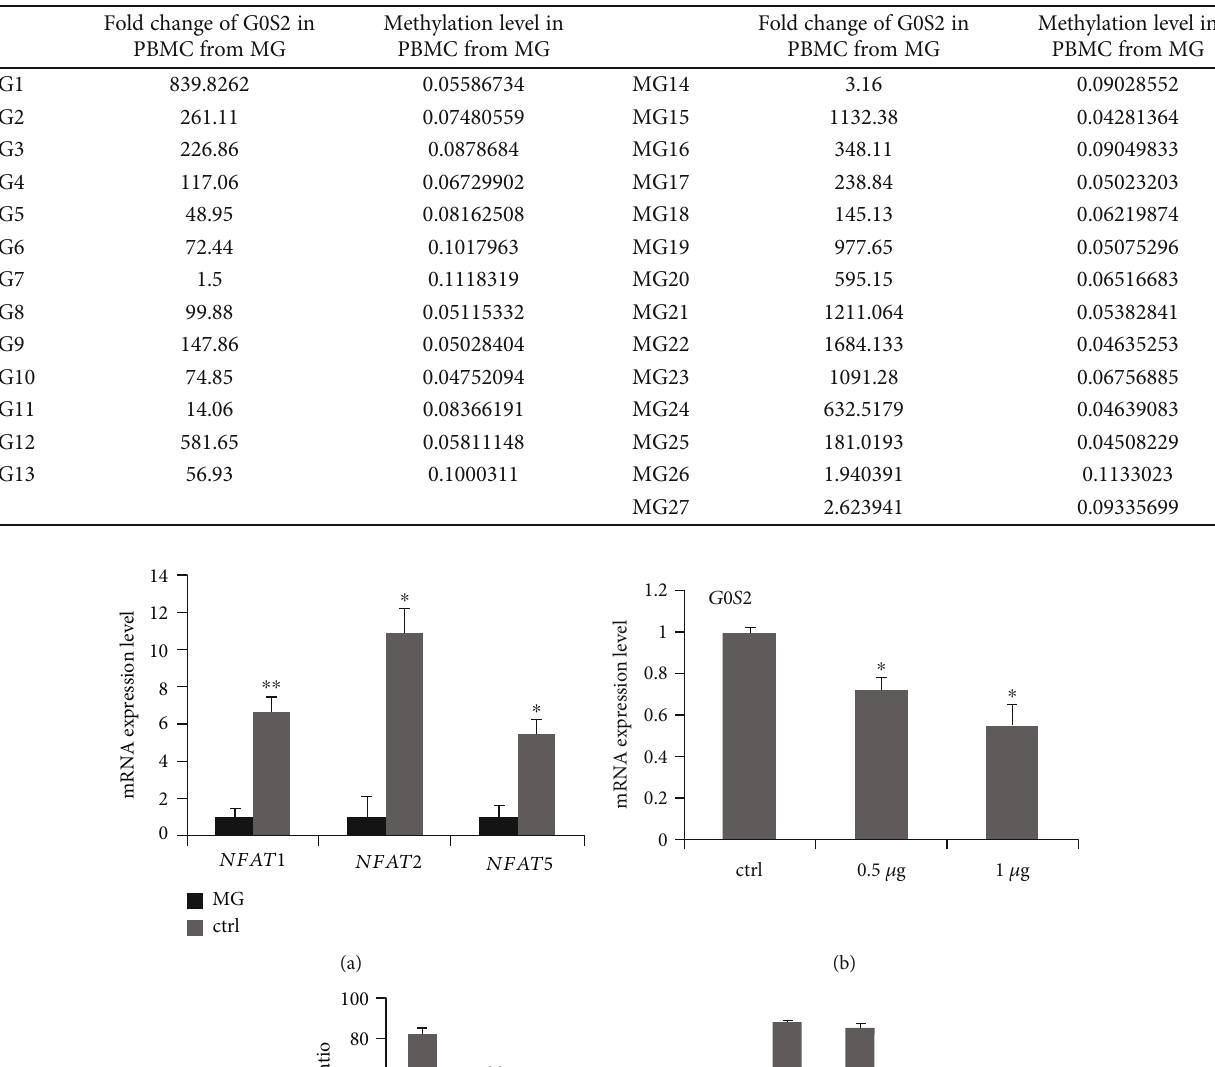
Table 2: Fold change of G0S2 and methylation level in PBMC from the same MG patients.